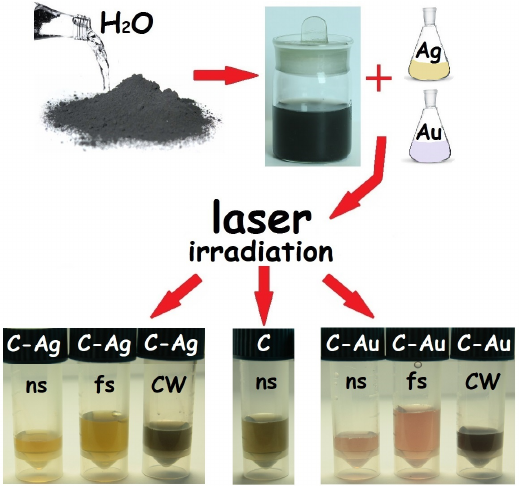
Figure 1. Scheme of hybrid ShC–metal nanoparticle preparation. The average diameter of ShC nanoparticles increases from 100 nm up to 291.1 ± 6.4